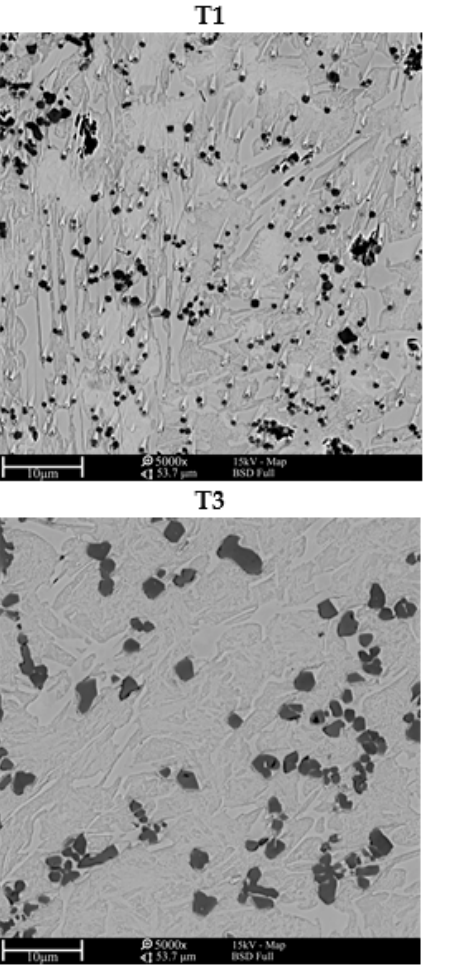
Figure 5. The microstructure of homogeneous laser alloyed surface layers (designation in accordance with Table 3).